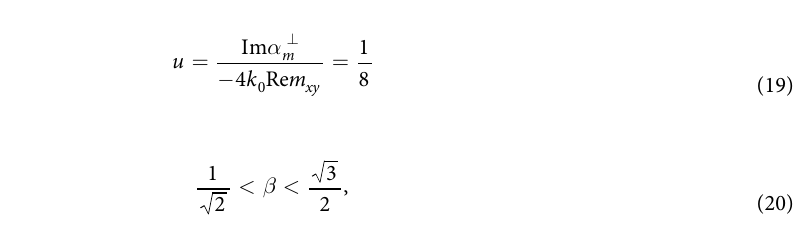
Figure 5. Electric and magnetic dipole-quadrupole-interaction terms, α ⊥ ⁎ q Im( ) function of dielectric permittivity ε ′ . Parameters: μ = 1, ε ″ = 0, k 0 R =